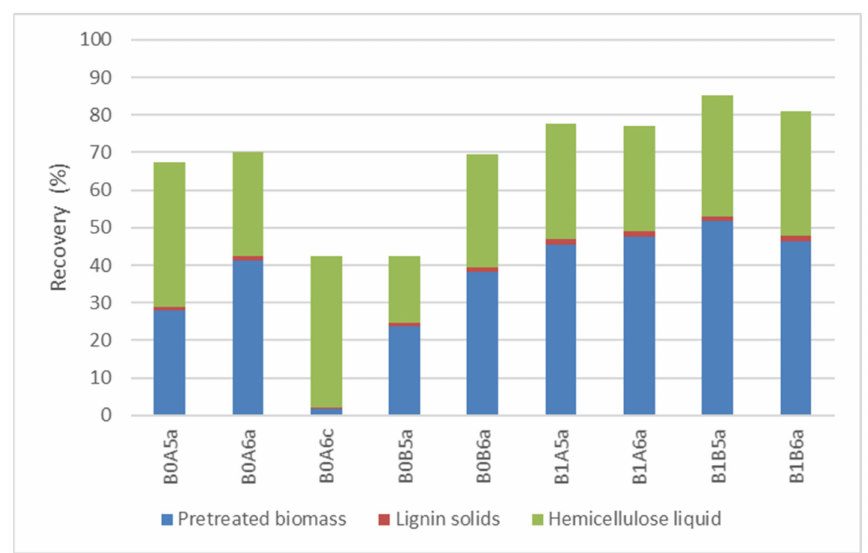
Figure 4. Hemicellulose distribution in the different fractions. Representation of the codes: 0— pretreatment at 200 ◦ C; 1—pretreatment at 180 ◦ C; A—pretreatment time of 15 min; B—pretreatment of 30 min;5—50% v / v ethanol content; 6—60% v / v ethanol content; a—no catalyst added; c—1% w / w biomass H 2 SO 4 .